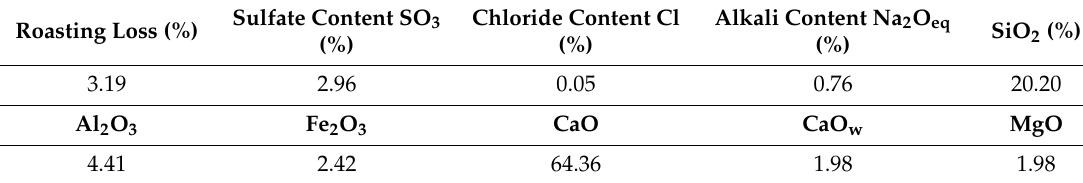
Table 3. Chemical properties of cement CEM I 42.5R.